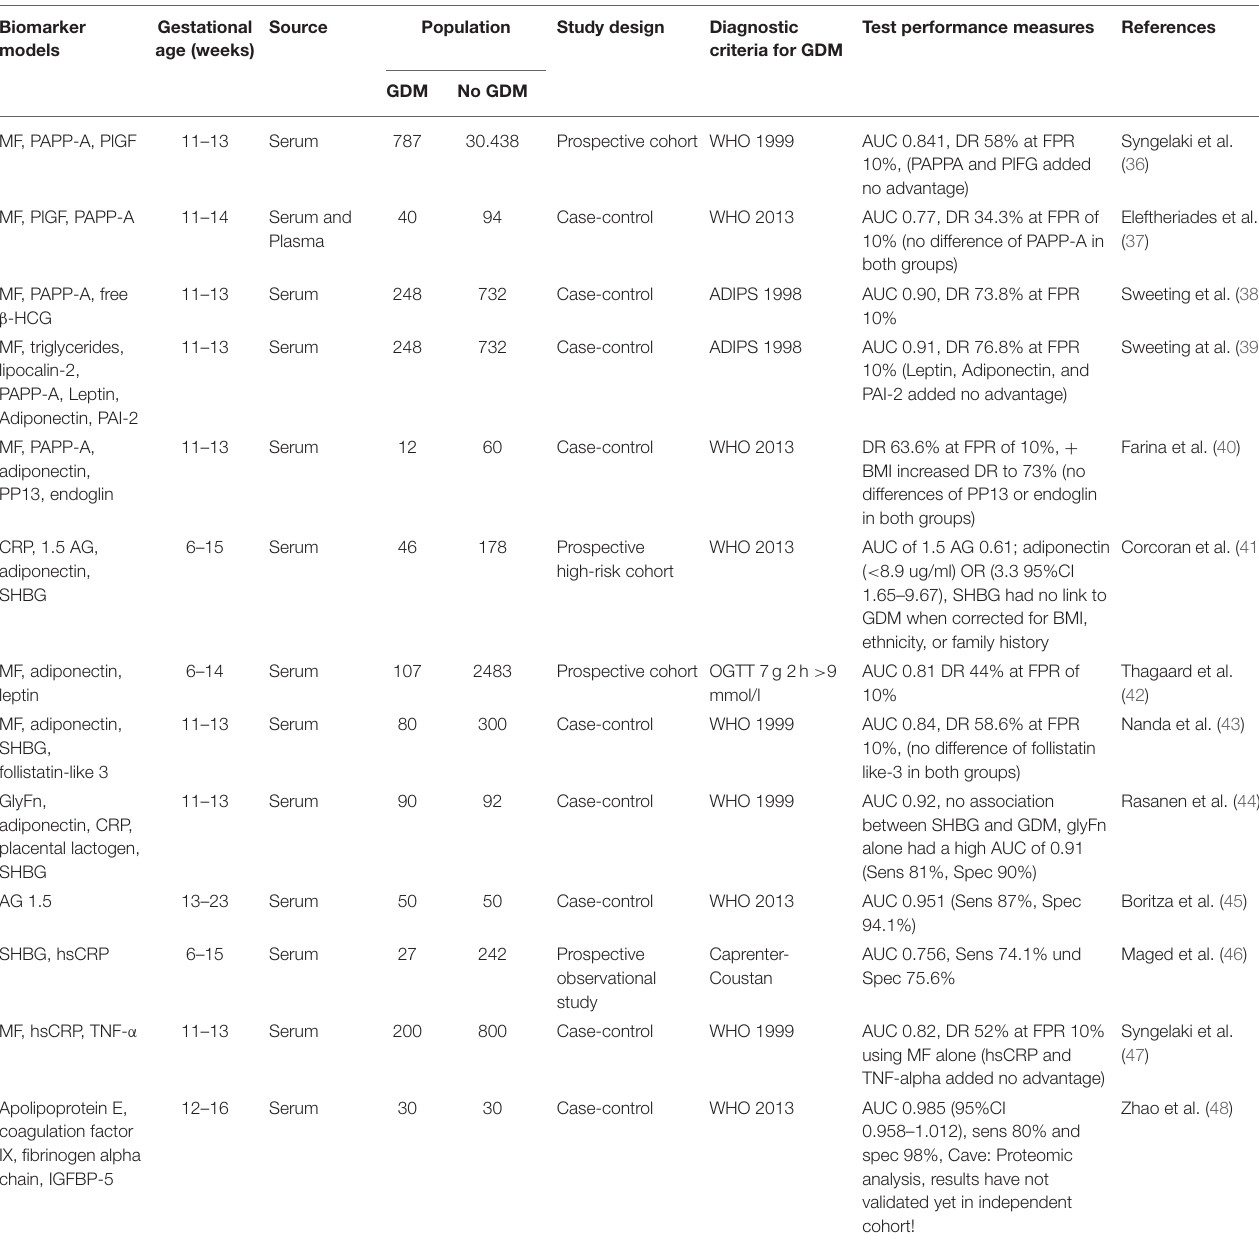
TABLE 1 | Summary of biomarkers tested in a multivariate model for later development of gestational diabetes. Biomarker